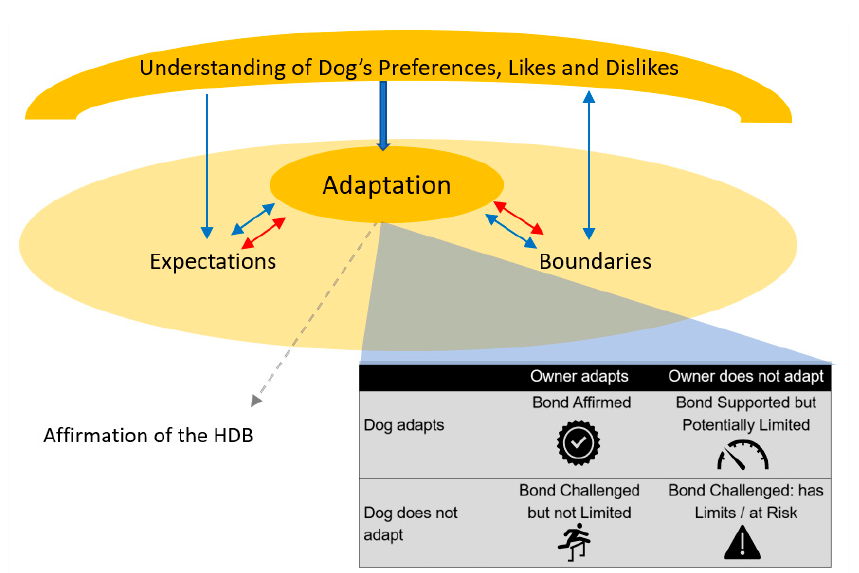
Figure 1. Suggested theory of how the qualitative themes, which emerged through semi-structured interviews, may relate to one another inside a human–dog bond (HDB). Solid lines propose there is a direct impact on the HDB, while the dotted line proposes a non-direct impact.